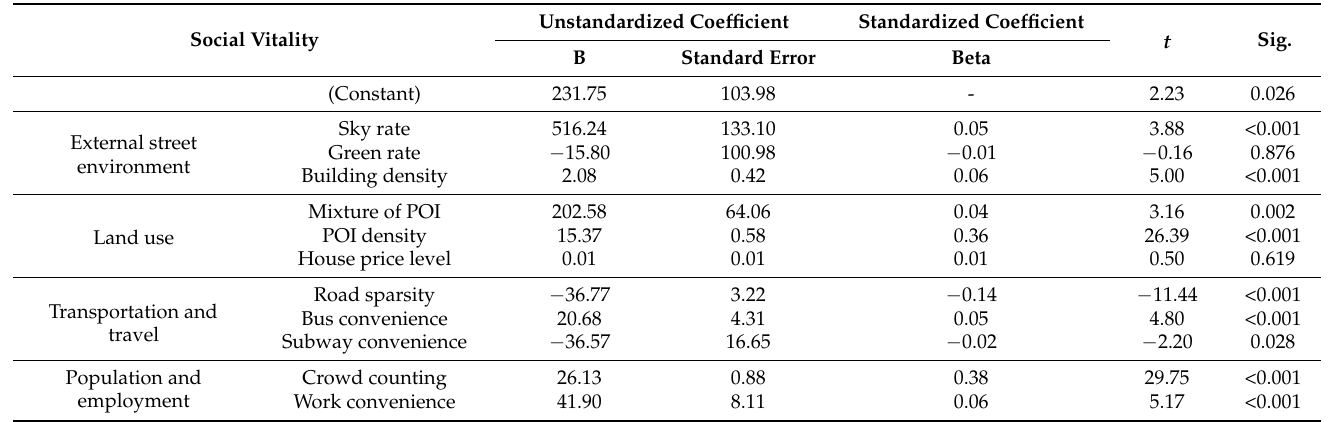
Table 6. Regression coefficient results for social vitality.